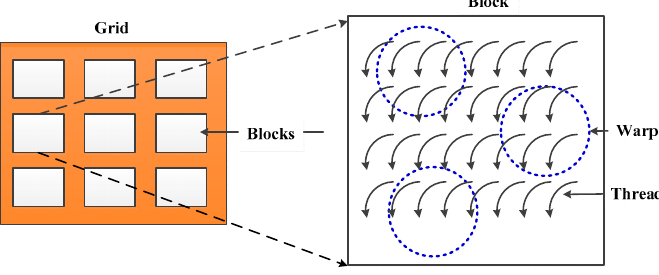
Figure 6. Schematic visualization of a hierarchy of thread groups.